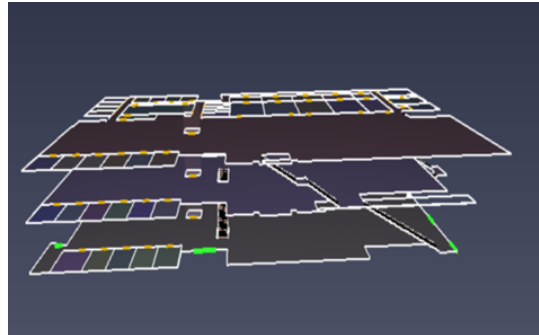
5 Three-dimensional evacuation model after